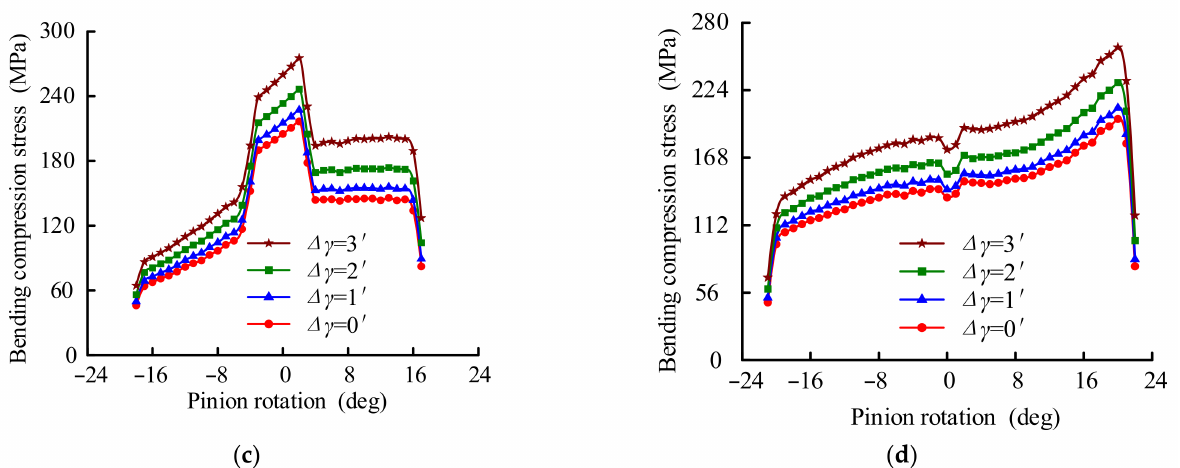
Figure 20. Comparison of bending compressive stress between novel gears and involute gears with different misalignment errors. ( a ) Unmodified involute gears; ( b ) Unmodified novel gears; ( c ) Modified involute gears; ( d ) Modified novel gears.